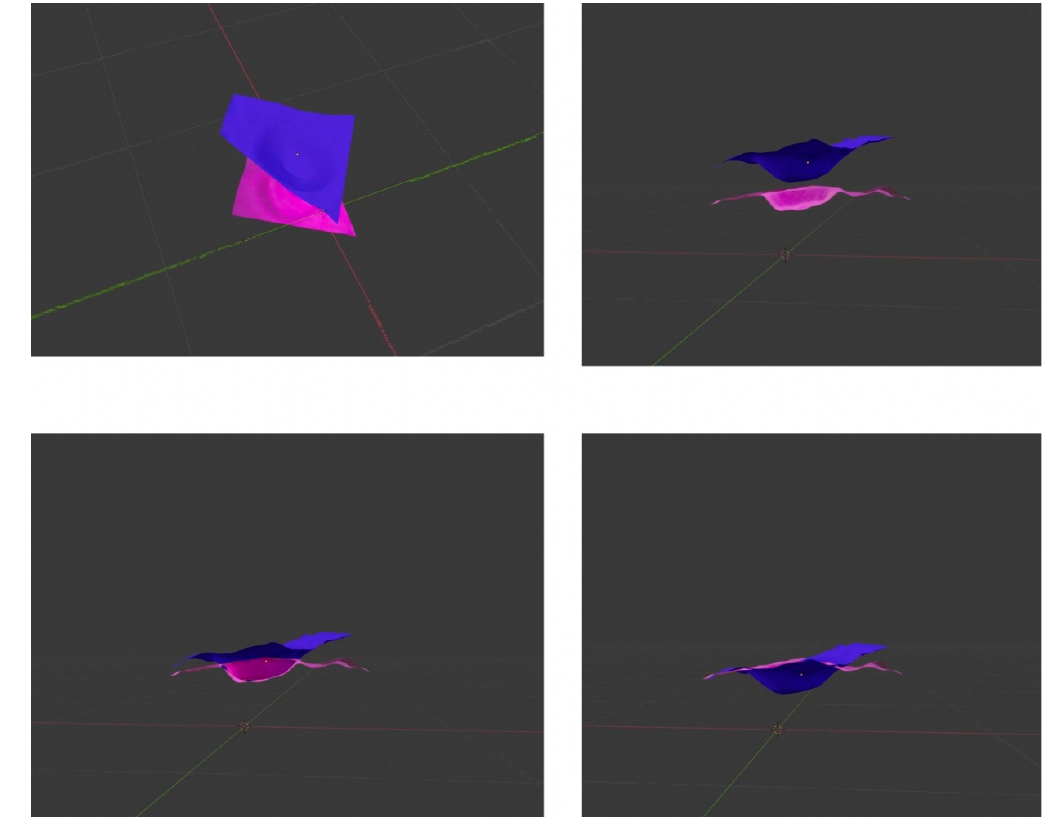
Figure 10. Mosaic of 4 3D blending images of inverted Ahuna Mons (blue) and Crater B (pink) 3D objects to show how Ahuna Mons fits inside Crater B.